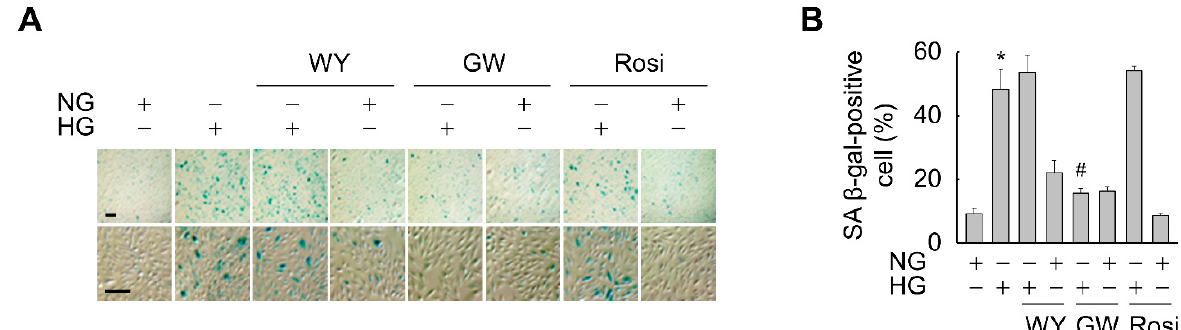
Figure 2. Ligand-activated PPAR δ , but not PPAR α or PPAR γ , attenuates HG-triggered senescence of ARPE-19 cells. ( A , B ) Cells pretreated with WY-14643 (WY, 10 μ M), GW501516 (GW, 100 nM), or rosiglitazone (Rosi, 10 μ M) were exposed to NG (5.6 mM) or HG (30 mM). After incubation for 48 h, SA β -gal staining was performed ( A ) and SA β -gal-positive cells were quantified ( B ). Cells from at least six randomly chosen fields were scored ( n = 100 per group). Scale bars indicate 100 μ m. Quantitative data are expressed as means ± S.E. ( n = 6). * p < 0.01 compared with the NG-treated group. # p < 0.01 compared with the HG-treated group.